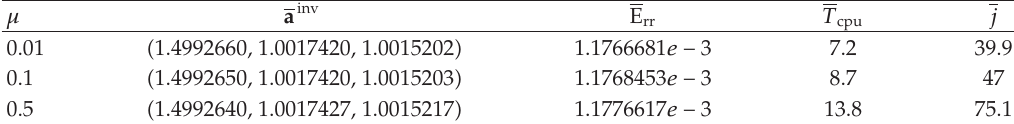
Table 7: Inversion results with regularization parameters for ε (cid:8)